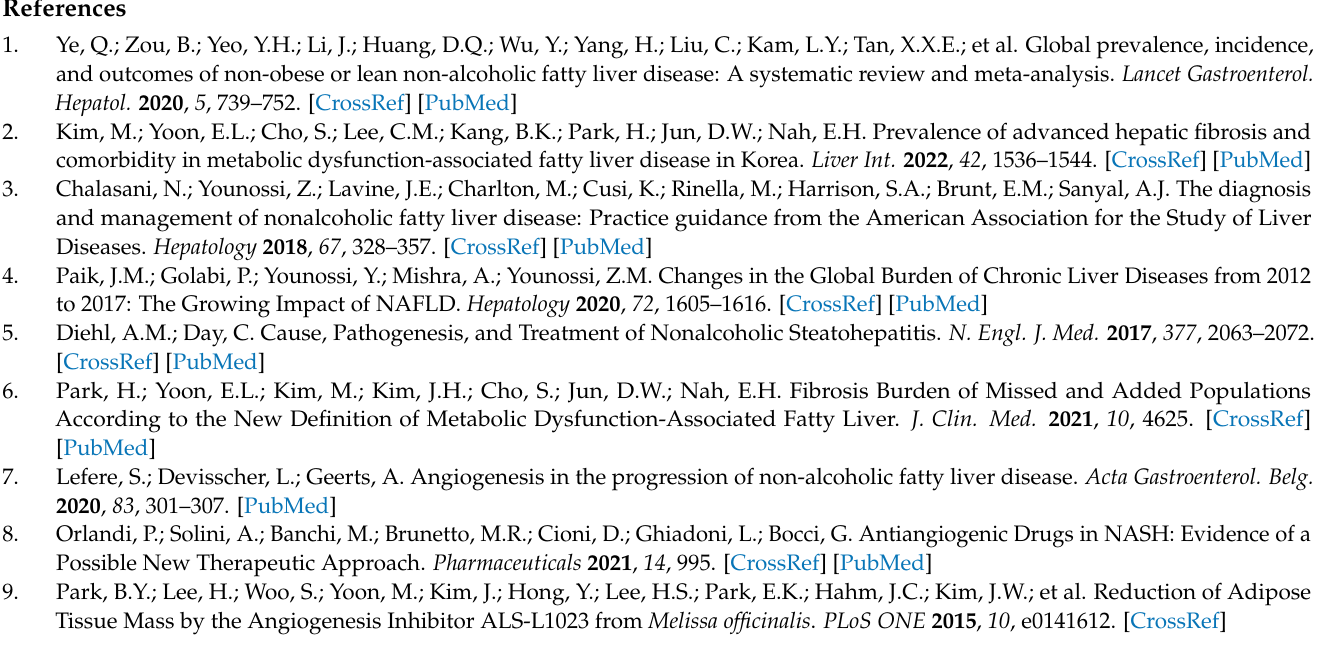
Table S3: Change in serum biomarkers from baseline to week 8 and week 16 in the PPS; Table S4: Significant changed miRNAs from ALS-L1023 treated patients; Table S5: 6 miRNAs and their putative target transcripts; Table S6: KEGG analysis using 499 putative target